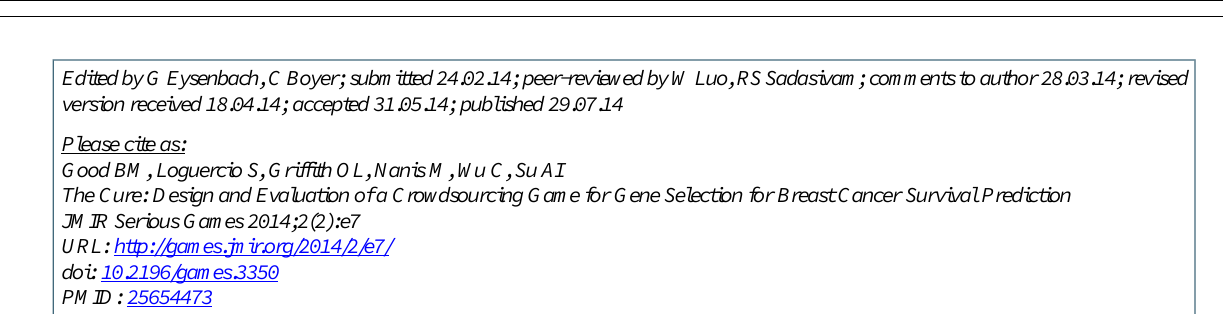
GWAP: games with a purpose RFRS: Random Forest Relapse